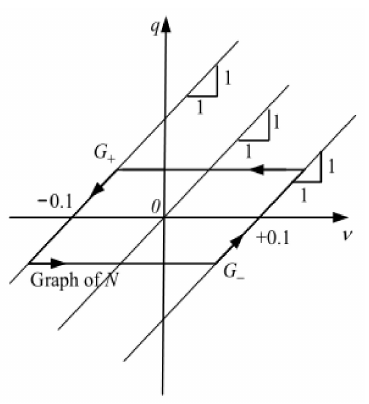
Figure 11. Equivalence of clearance characteristics.